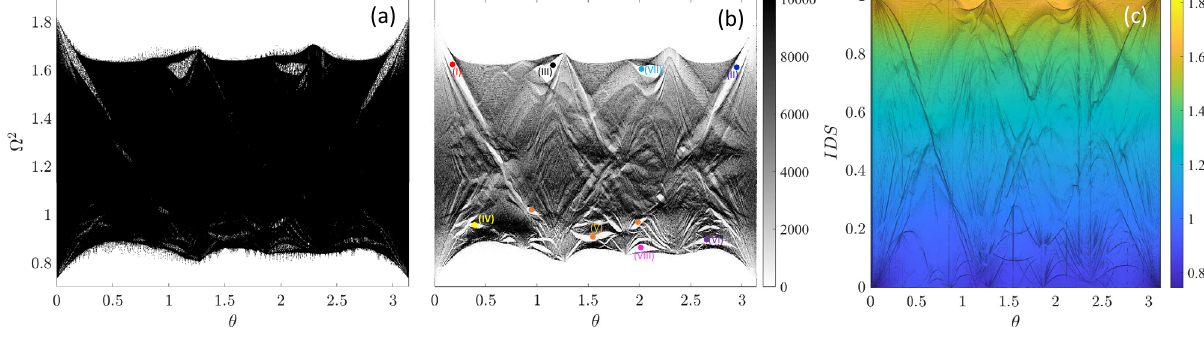
Fig. 3 Spectral properties of lattice with β ¼ π = conditions as a function of θ . The same result is repeated in ( b ), but color-coded by the associated density of states (colorbar). Particular gaps are marked by colored dots and labeled (I – VIII) for reference. c Integrated density of states (IDS) as a function of θ , where the color gradient represents Ω 2 .